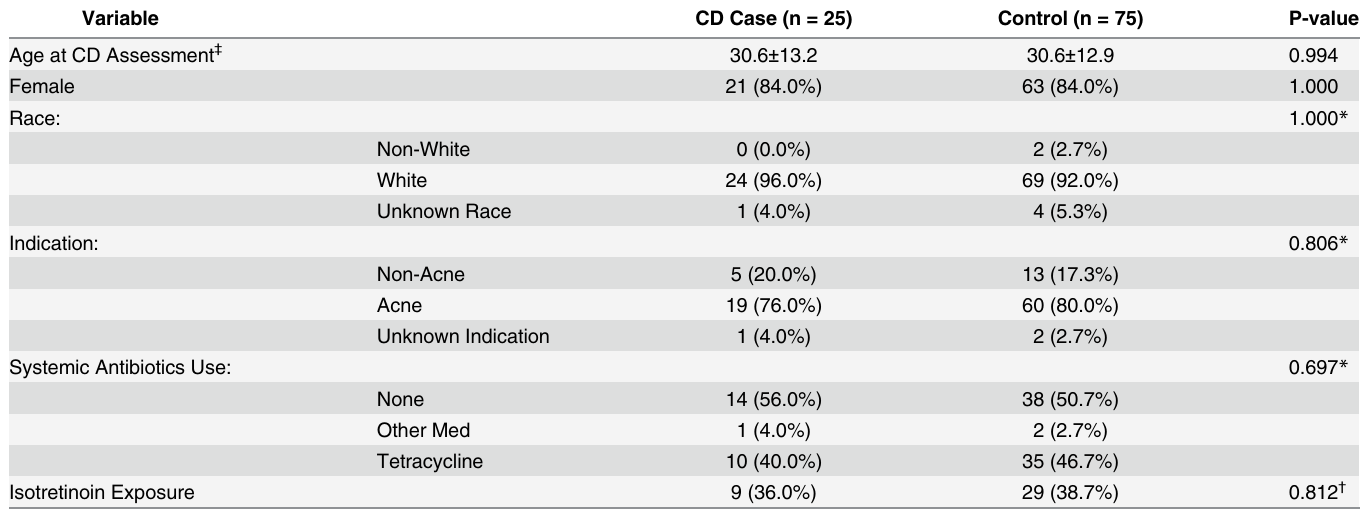
Table 1. Comparins Overt CD Cases and Controls.